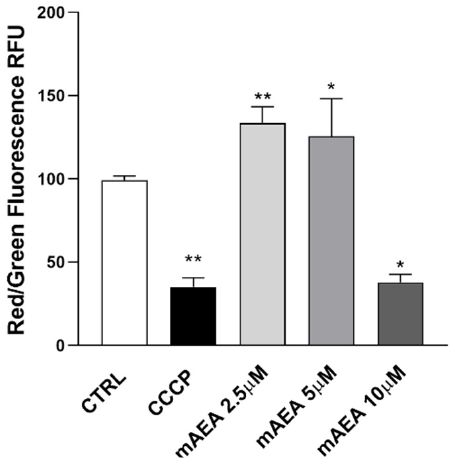
Figure 5. The polarization state of mitochondrial membrane was assessed after the cells were exposed to mAEA, at different doses (2.5, 5.0 and 10 μ M) for 24 h, or to the oxidative phosphorylation inhibitor CCCP (50 μ M) used as a positive control for ( Δψ m) decrease. Values are expressed as ratio of red (~590 nm)/ green (~529 nm) fluorescent intensity. Ratio are presented as mean ± SEM of three independent experiments ( n = 3). [* p < 0.05, ** p < 0.01 vs. control cells (CTRL)].